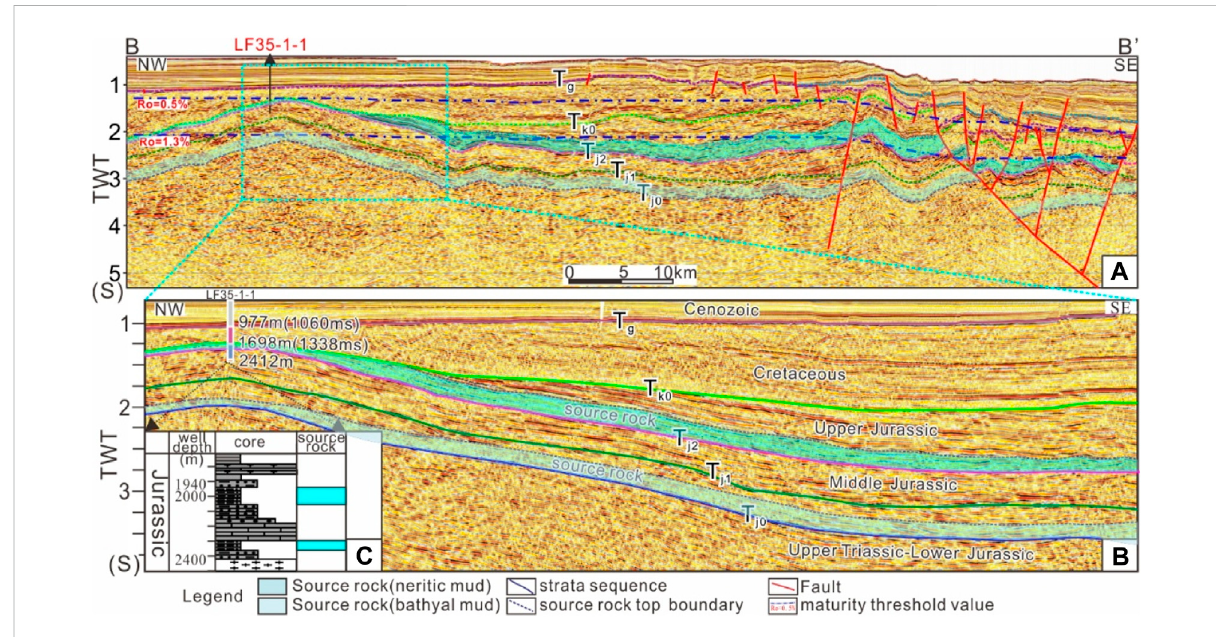
FIGURE 4 Source rocks characteristic of (A) two sets of source rocks revealed by seismic, location see Figure 1; (B) is the expanded view of (A) ; (C) source rocks revealed by Well LF35-1-1.